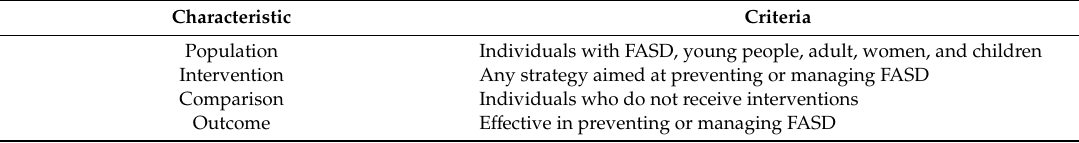
Table 1. Characteristics and criteria for PICO (Population, Intervention, Comparison, and